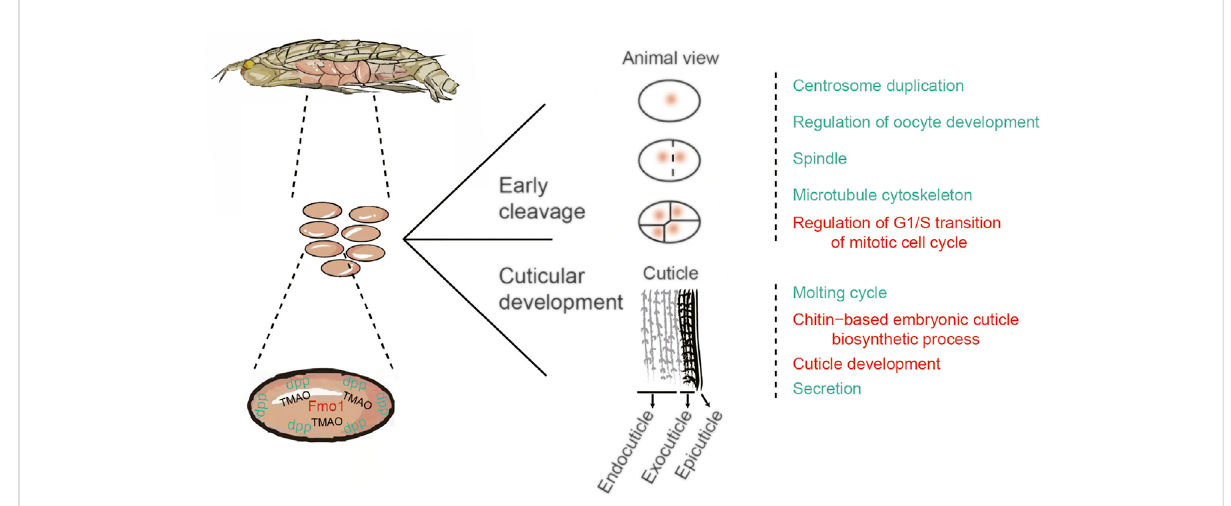
FIGURE 6 A schematic representation of the adaptive molecular evolution of the A. gigantea